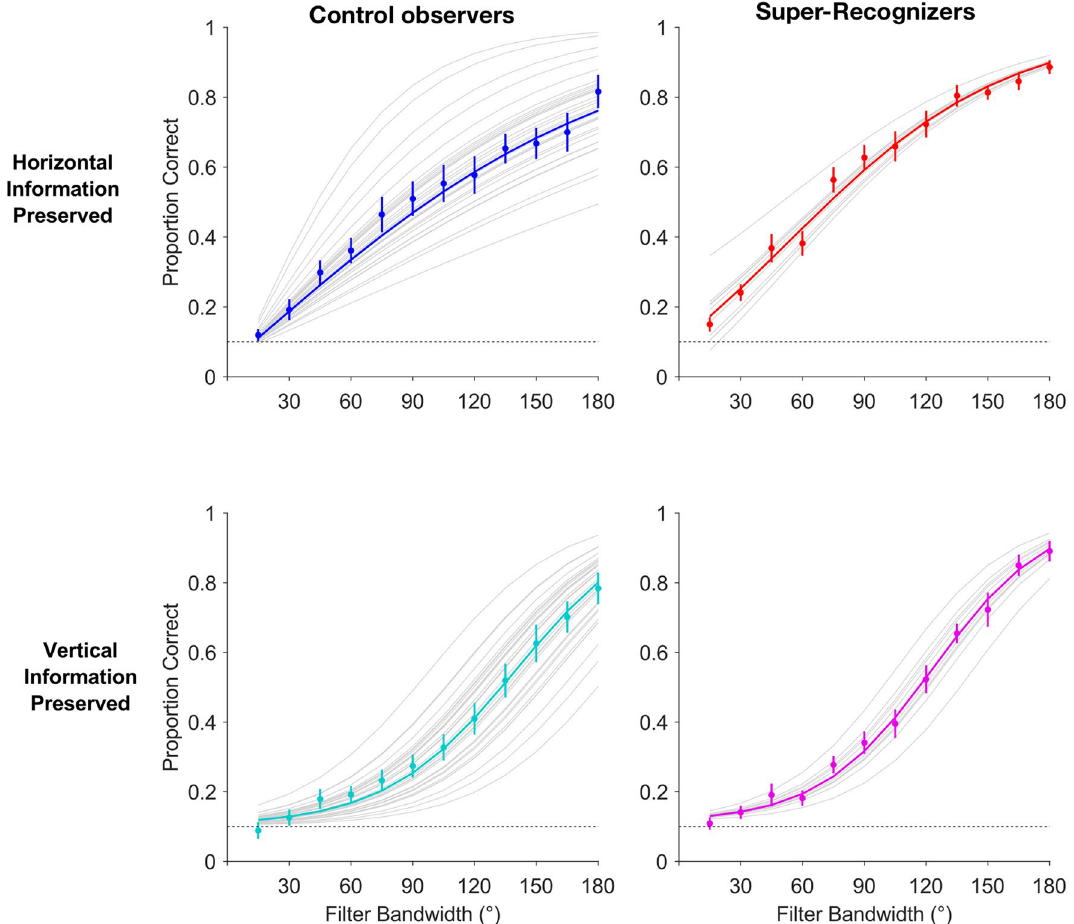
Figure 3. Logistic approximations of the psychometric function fitted to trial-level correct responding, accounting for both Group and Orientation as factors. Averaged data are grouped by column (control observers, left column; SRs, right column), with gray tracings in each displaying individual observers’ model fits for comparison. Averaged data were further split by filter orientation, and are plotted separately for images retaining horizontal (top row) and vertical (bottom row) SF information, across filter bandwidth conditions. Error bars represent ± 1SEM; dotted lines represent chance performance.